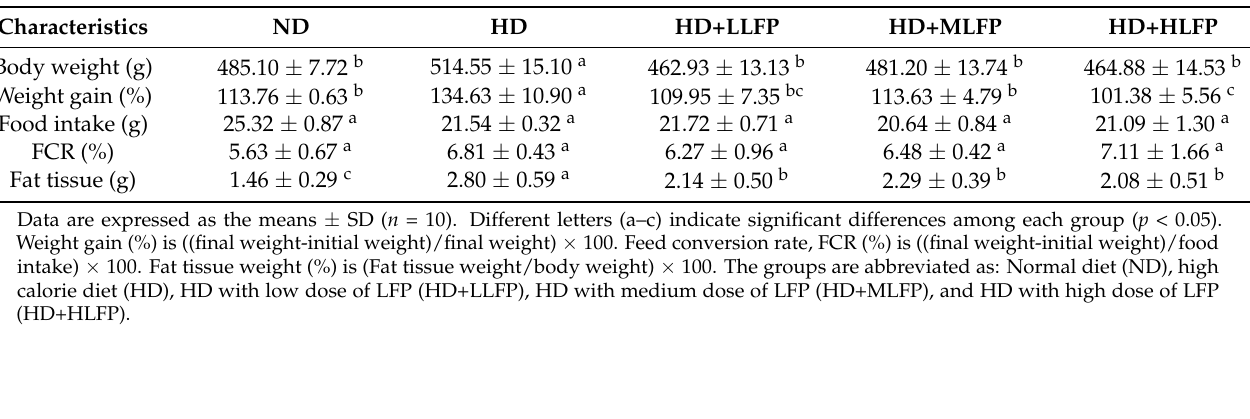
Table 1. Effect of LFP on animal characteristics in rats fed a high-calorie